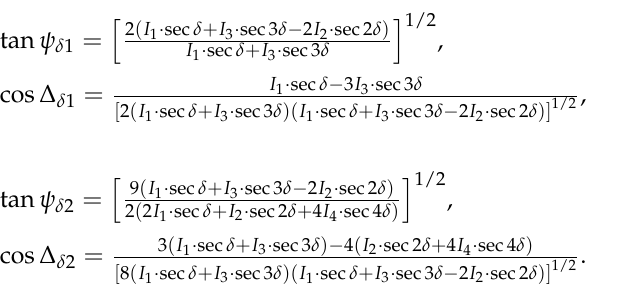
Figure 8. Experimental data (points) and fitted curves (lines) of MAREs versus azimuthal errors (for δ θ A : δ θ P = 2:1, the horizontal axis represents δ θ A ). The polarizing elements were rotated in the opposite direction with the same abso- lute values of azimuthal errors to study the directional dependence on accuracy. The spec- tra of ψ and Δ , measured for a series of the same absolute values, showed a high con- sistency for both ± δ θ P and ± δ θ A , as observed in Figure 9. Consequently, the accuracy of the RPAE was found to be less dependent on the direction of the azimuthal error in terms of the acquired spectra.